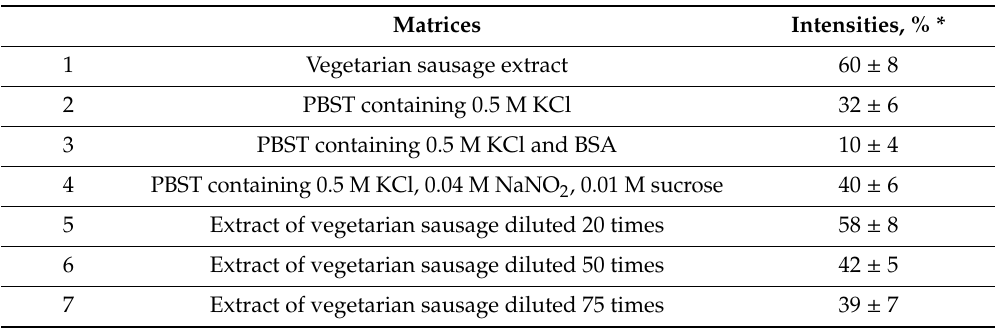
Table 1. Staining intensities of the test strip analytical zone at TnI concentration of 100 ng / mL in various matrices and diluting solutions (%); n = 3.